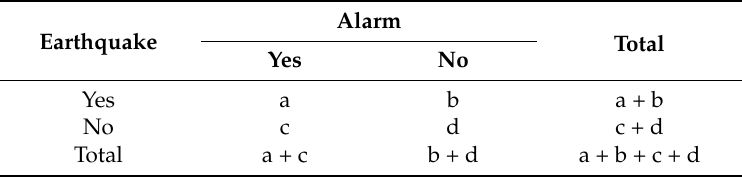
Table 3. The format of cross-tabulation tables consisting of the presence or absence of earthquakes and anomalies in milk yields; a represents the number of earthquakes occurring in alarm days, b represents the number of earthquakes occurring in no alarm days; c represents the number of alarm days without targeted earthquakes; d represents the number of no alarm days without targeted